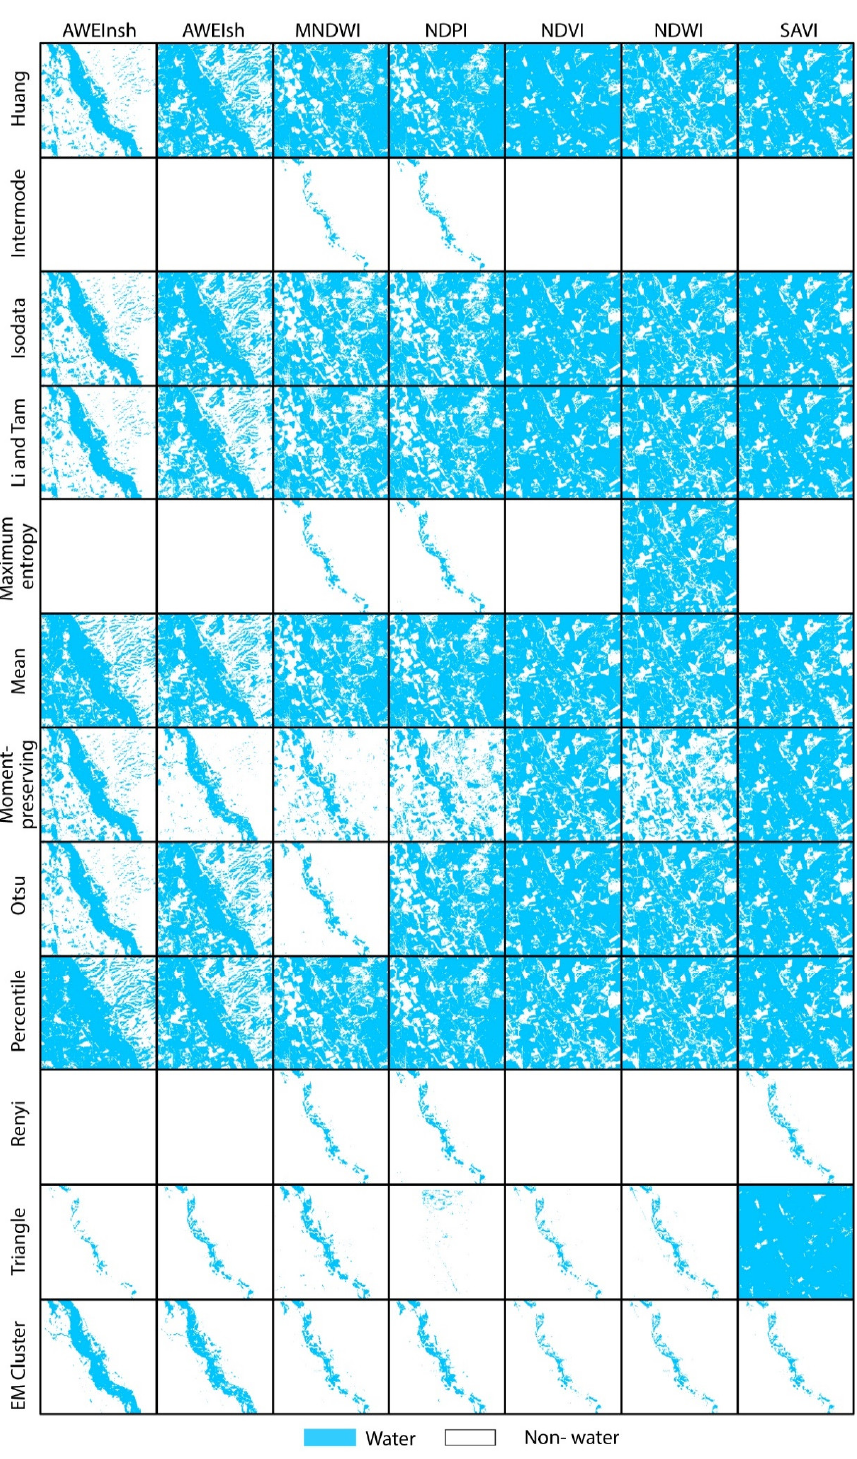
Figure 7. Flood-areas extraction performances generated using all indexes by each mapping method (refer to Table 5).